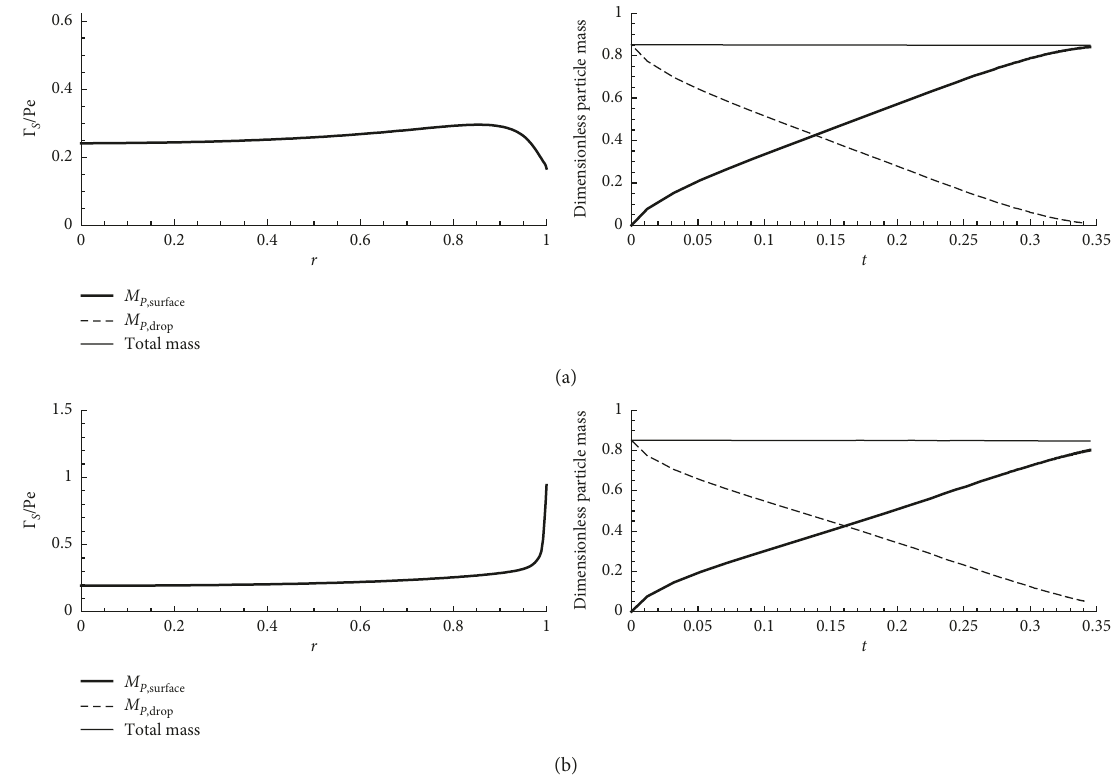
Figure 9: Final deposition profile (left column) and the particle mass versus time (right column) for the same Pe and Da but different Da (a) Pe � 1, Da � 5, Da − 1 � 0; (b) Pe � 1, Da � 5, Da − 1 � 0.5; (c) Pe � 1, Da � 5, Da − 1 � 5; (d) Pe � 1, Da � 5, Da − 1 � 25. Initial AR � 0.5, H �